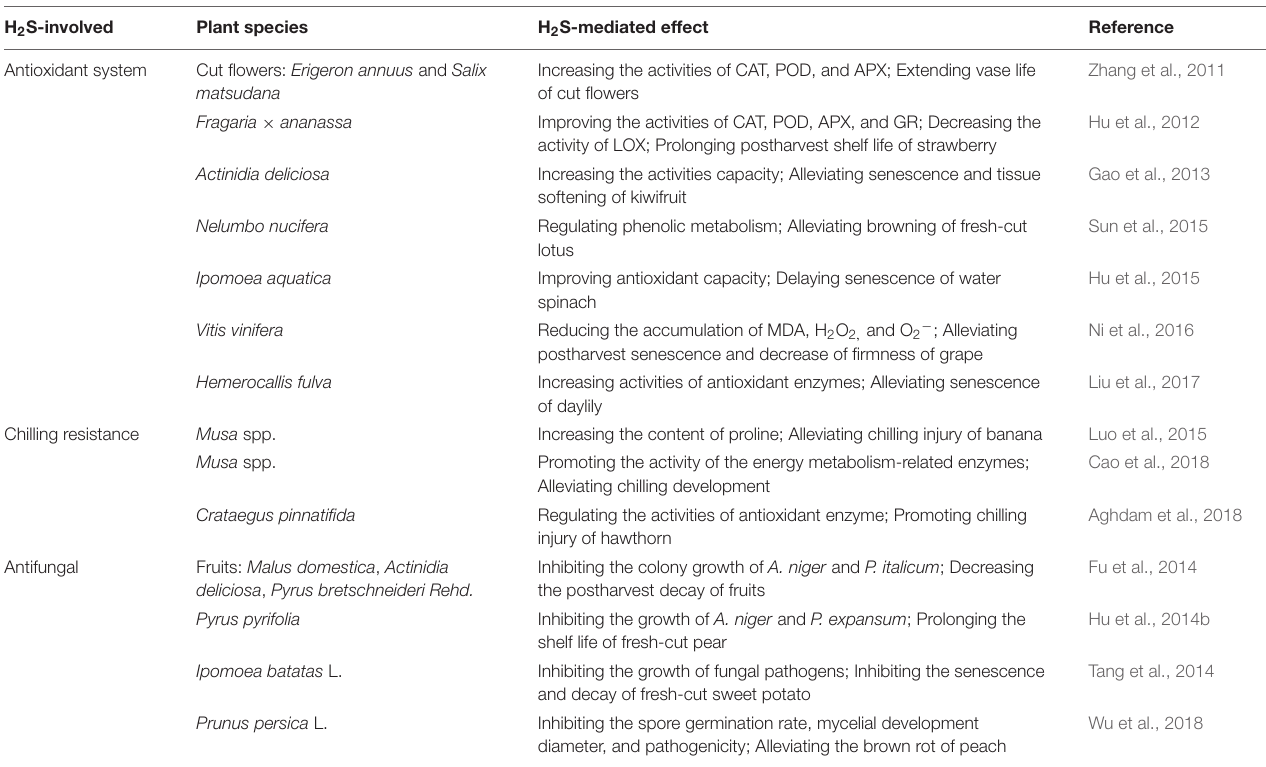
TABLE 1 | Effects of hydrogen sulfide on postharvest senescence of horticultural